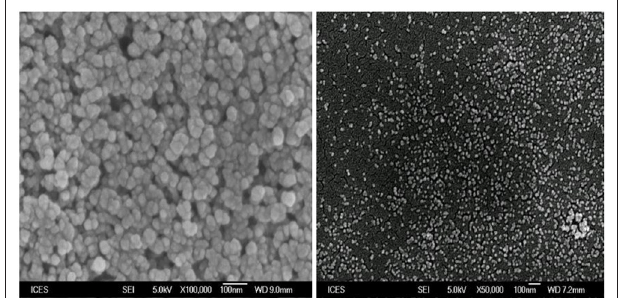
FIGURE 2 | SEM image of nanoparticles: Right : FNP; Left : CNP.